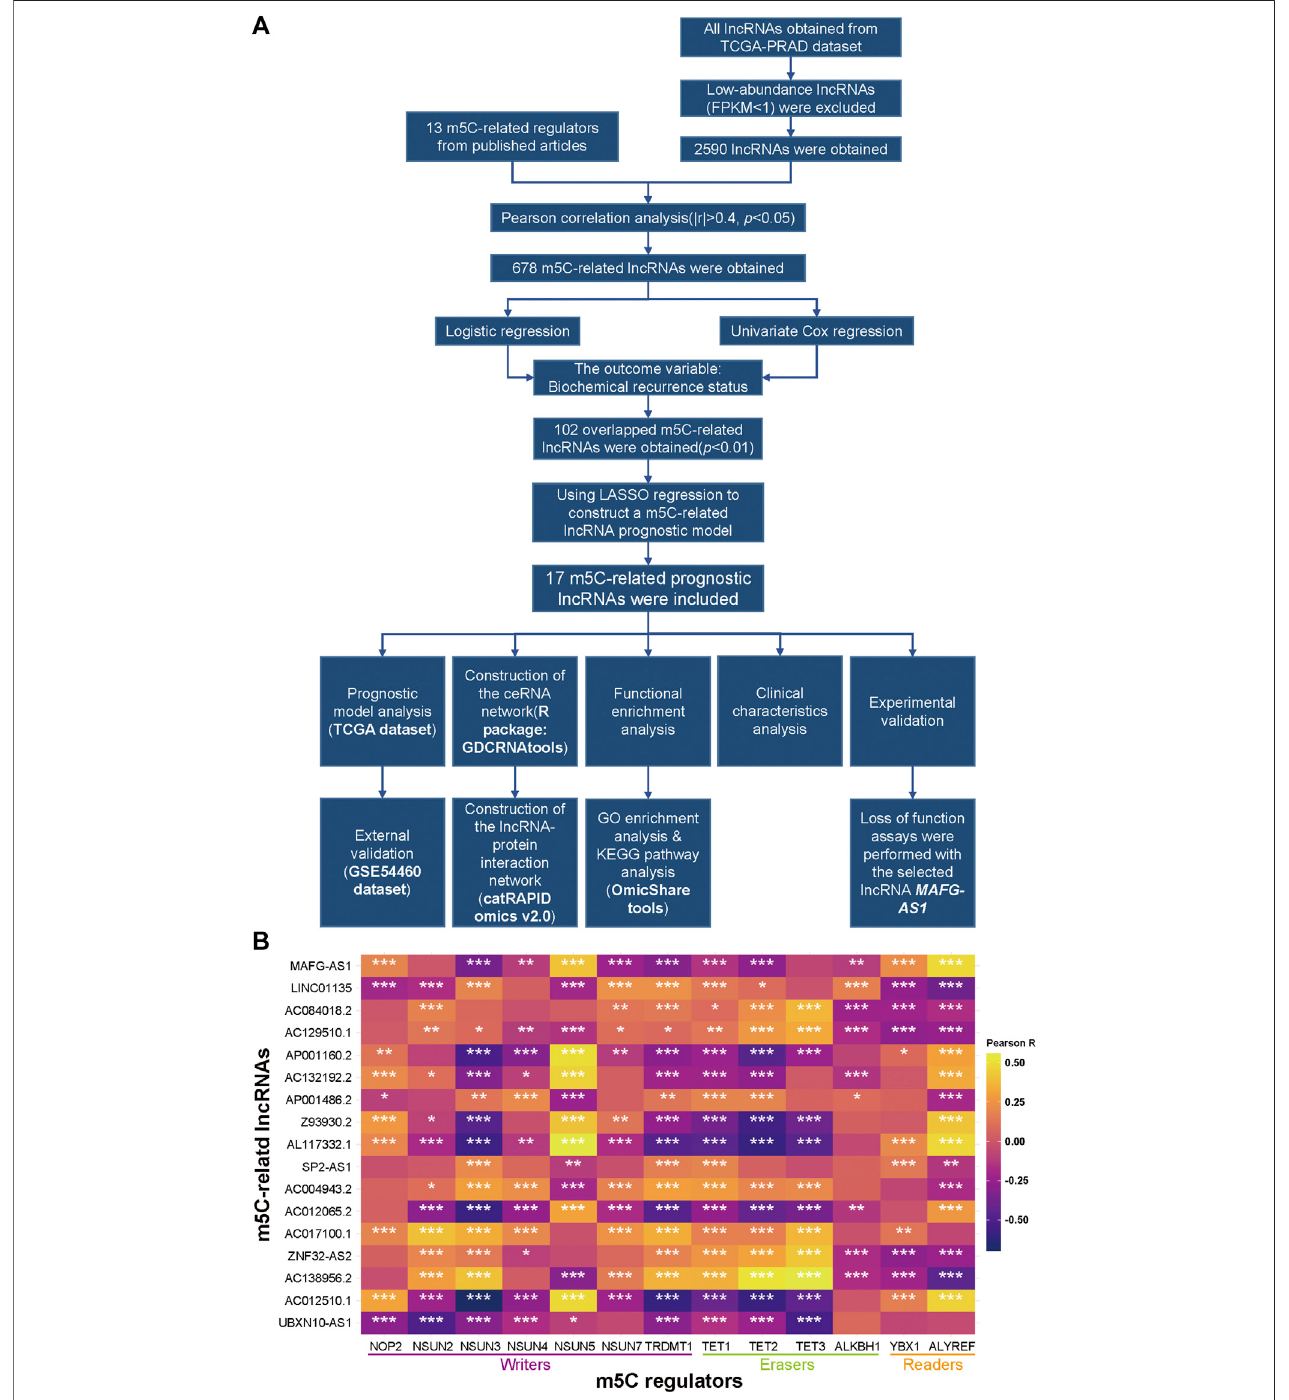
FIGURE 1 | Identi fi cation of m5C-related lncRNAs in TCGA-PRAD. (A) Flow chart. (B) Heatmap of the correlations between m5A-related genes and the 17 prognostic m5C-related lncRNAs. * p < 0.05, ** p < 0.01, and *** p < 0.001.